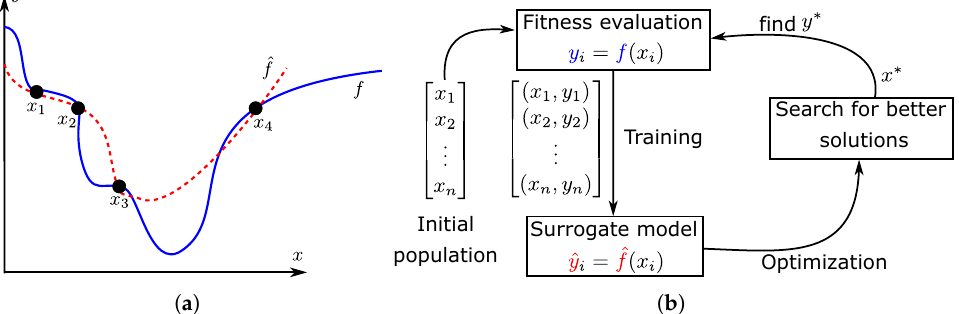
Figure 9. Visualization of how AL is combined with optimization algorithms. ( a ) Using only four fitness evaluations (i.e., four initial points), a surrogate model ( ˆ f ) is built to approximate the original fitness function ( f ). ( b ) Some initial points ( x 1 , x 2 , . . . , x n ) will be evaluated by using the original fitness function ( f ), and these initial points with their fitness values ( { ( x 1 , y 1 ) , . . . , ( x n , y n ) } ) will be used for training a surrogate mode ( ˆ f ), which helps to find better